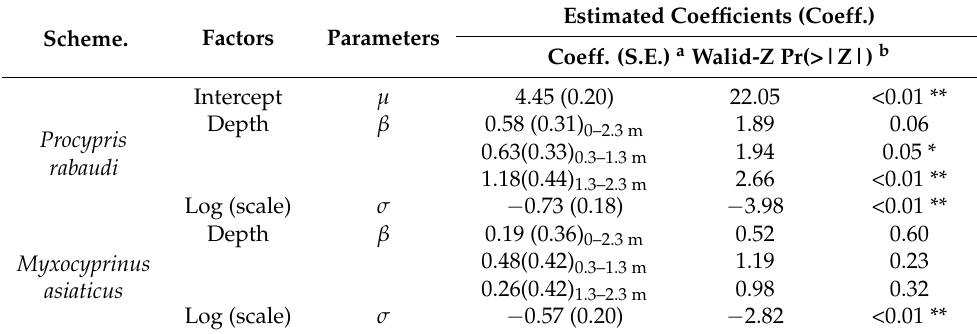
Table 2. Estimated parameters for the accelerated failure time (AFT) model of the influence of water depth on the survival of juvenile Procypris rabaudi and juvenile Myxocyprinus asiaticus exposed to total dissolved gas (TDG) supersaturation.